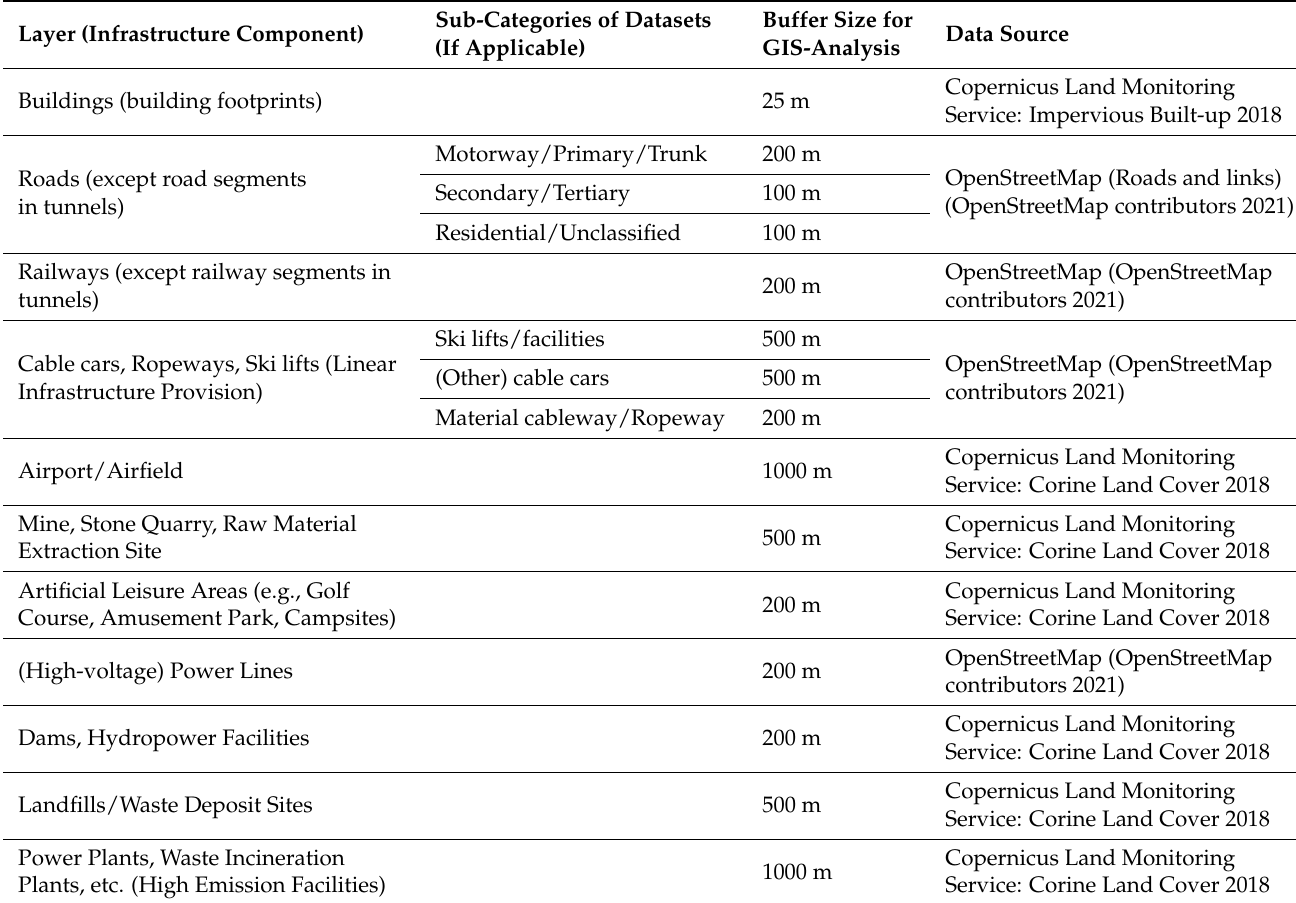
Table 2. Layers and datasets used in the GIS analysis (Source: own compilation; choice of layers and buffer sizes derived from Nischik/Pütz